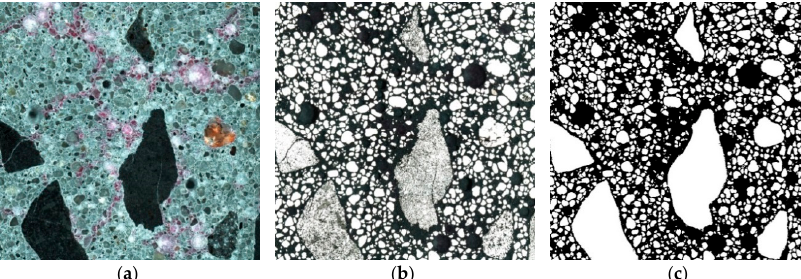
Figure 2. Image of the sample: ( a ) ordinary light illumination, ( b ) illumination enhanced with the attachment and ( c ) binary image of the aggregate after correction.